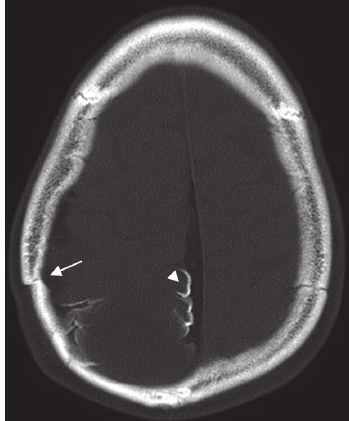
Figure 3: The porencephalic cyst directly communicates with the posterior horn of the right lateral ventricle (arrow) with adjacent cerebral lipomatosis (arrowhead) and cerebral